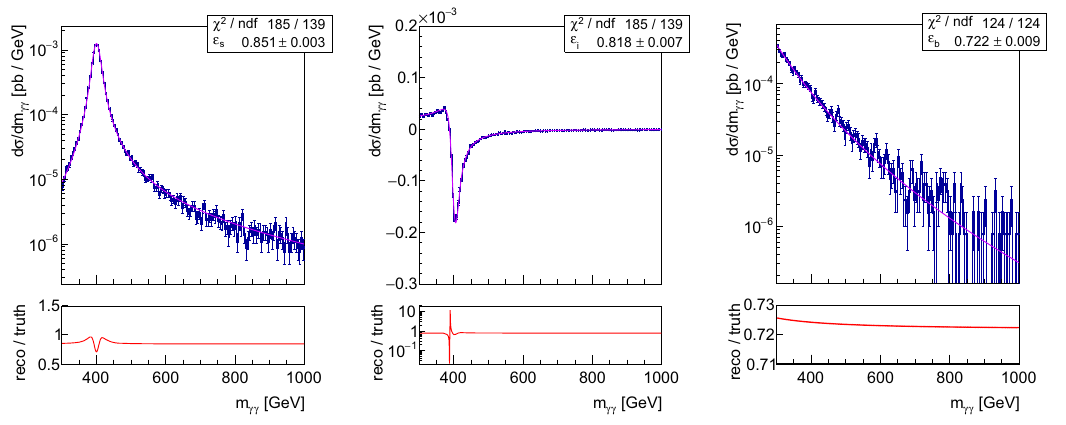
parameter in each of the fits is ε , the event reconstruction efficiency. The ratio of the best-fit function and its corresponding truth-level dis- tribution is plotted beneath each